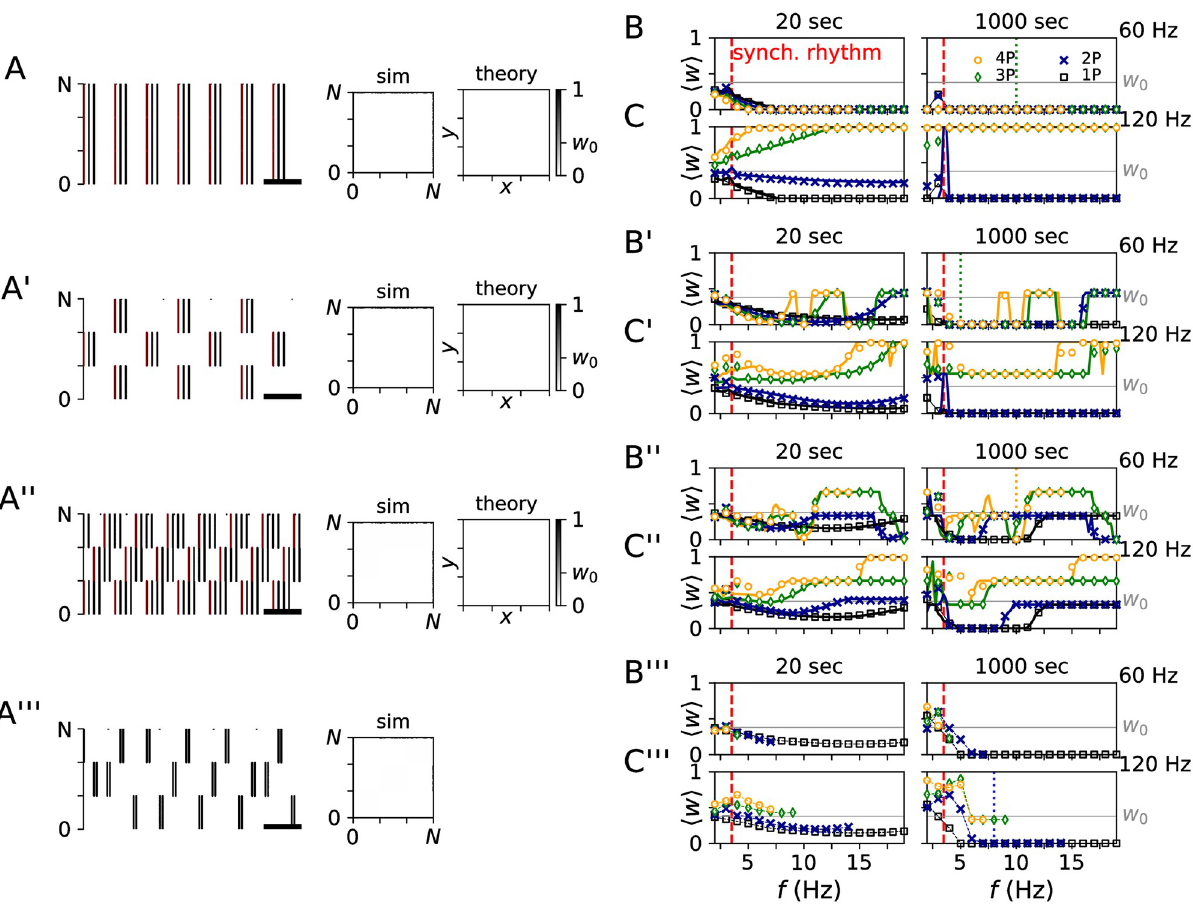
Fig 8. Decoupling effects of three PMCS patterns compared to decoupling by CRS RVS. A: Raster plot of spiking activity of LIF neurons after 1000 sec of periodic stimulation ( Δ α 1/2 = 0) using burst stimuli of three pulses per burst and an intraburst frequency of 60 Hz. Furthermore, snapshots of the synaptic weight matrix of the LIF network (sim) and the corresponding theoretical approximation obtained from Eq 1 (theory) are shown. Successful stimulation-induced decoupling led to synaptic weights that were close to zero (white). B, C: The mean synaptic weight after 20 sec and 1000 sec of periodic stimulation as function of the stimulation frequency, f , for single-pulse stimuli (1P) and burst stimuli with two (2P), three (3P), and four (4P) pulses per burst (see legend). Panels B and C show results for an intraburst frequency of 60 Hz (B) and 120 Hz (C), respectively. Markers show simulation results (averaged over five network realization) and curves theoretical approximations (Eq 4). Vertical lines mark the frequency of the synchronous rhythm prior to stimulation (red dashed line) and the set of stimulation parameters corresponding to the raster plot shown in panel A (colored dotted line), respectively. A’-C’ and A”-C”: Same as A-C but for PMCS with Δ α 1/2 = 0.5 (A’-C’) and Δ α 1/2 = 0.33 (A”-C”), respectively. (a’’’-c’’’): Similar plots for CRS RVS. Parameters: d e = 1 (all panels). A stim = 0.8 for PMCS with burst and CR RVS with single-pulse and burst stimuli. A stim = 0.4 for PMCS with single-pulse stimuli (B, C, B’, C’, and B”,